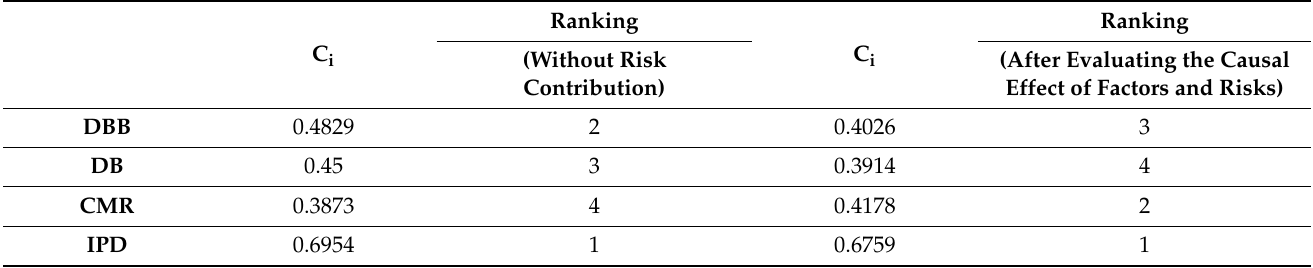
Table 9. Comparison of the rankings of PDSs—with and without risk